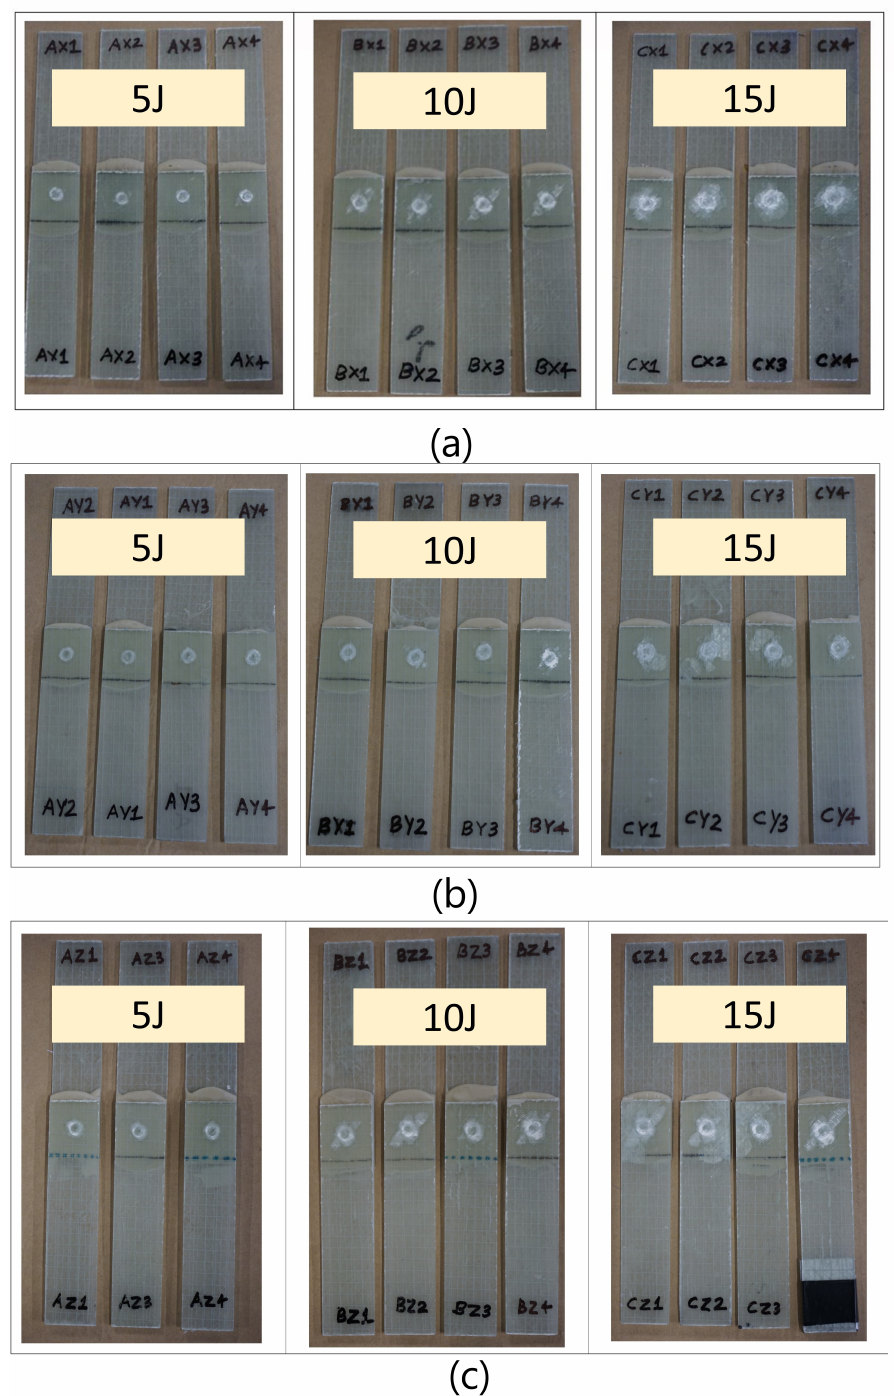
Figure 16. Damages in the joints subjected to different impact energies of 5 J, 10 J, and 15 J for bondline thickness: ( a ) 0.6 mm, ( b ) 1.6 mm, and ( c ) 2.6